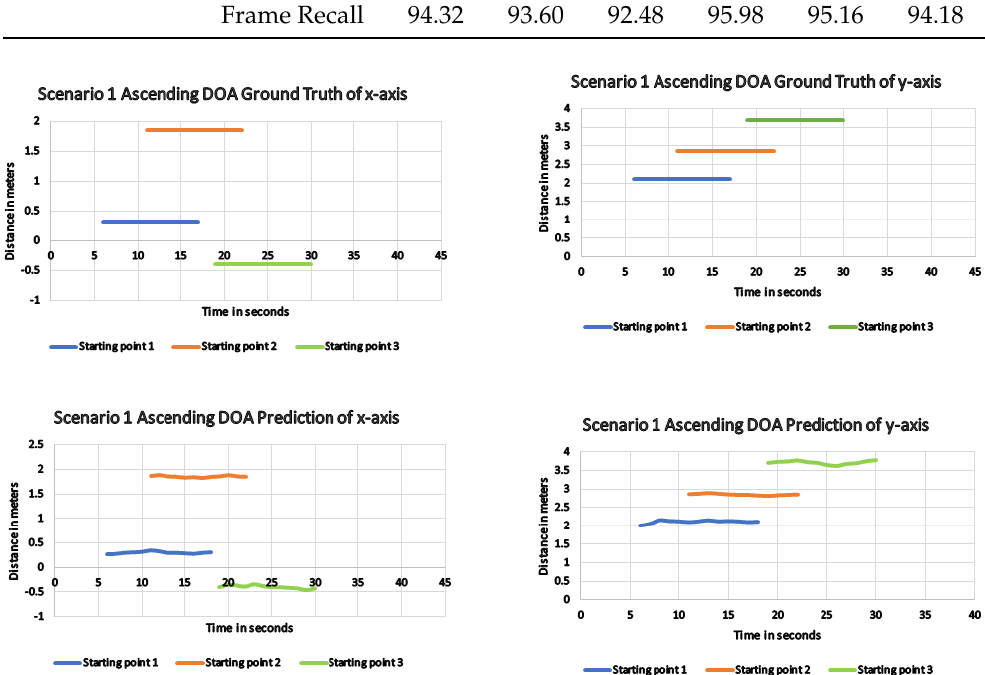
Figure 11. DOA result for the proposed method showing the difference in the actual and predicted x, y coordinates of scenario 1 ascending direction.